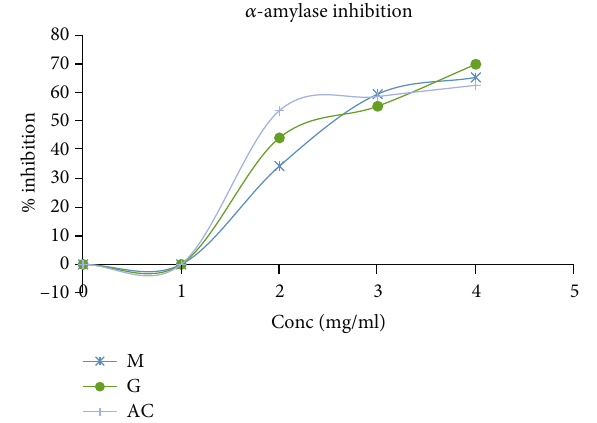
Figure 5: Percentage inhibition of α -amylase activity of plant extracts mixture, granules, and